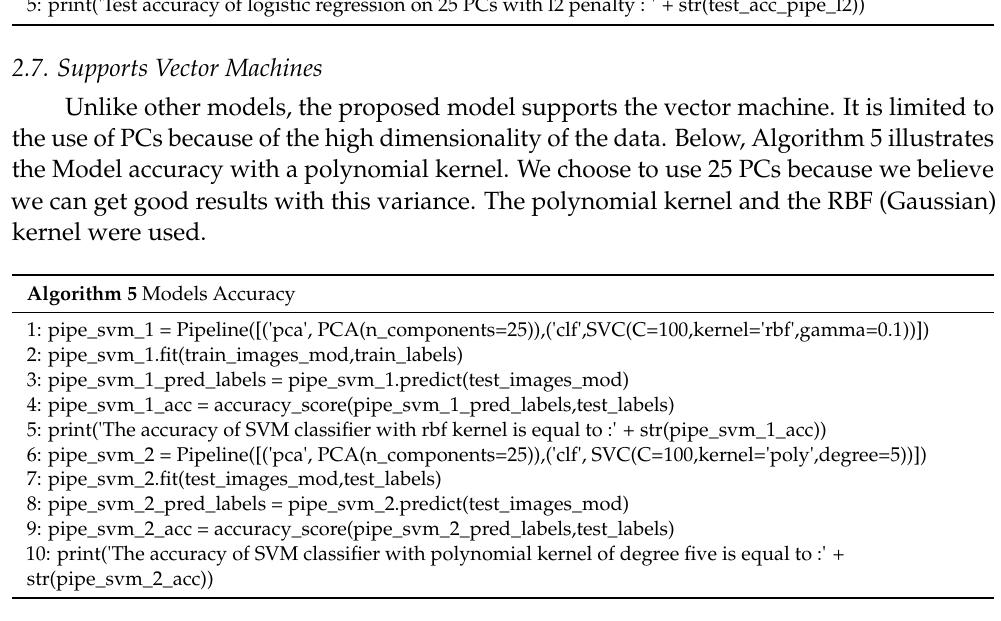
Algorithm 5 Models Accuracy